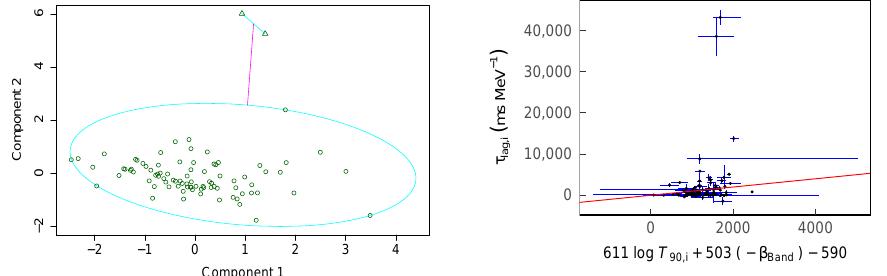
Figure 2. Similar to Figure 1, with the three parameters being τ lag,i , T 90,i and β Band . The outliers are GRBs 980425B and 030528A. The linear regression result is τ lag,i = ( 611 + 130 − ( − β ) − ( 590 + 440 ) . The adjusted R 2 is Band − 1100